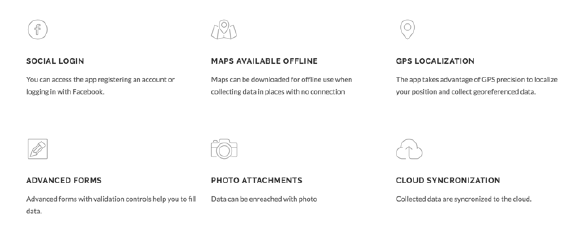
Figure 4. GBGEOApp: main features.